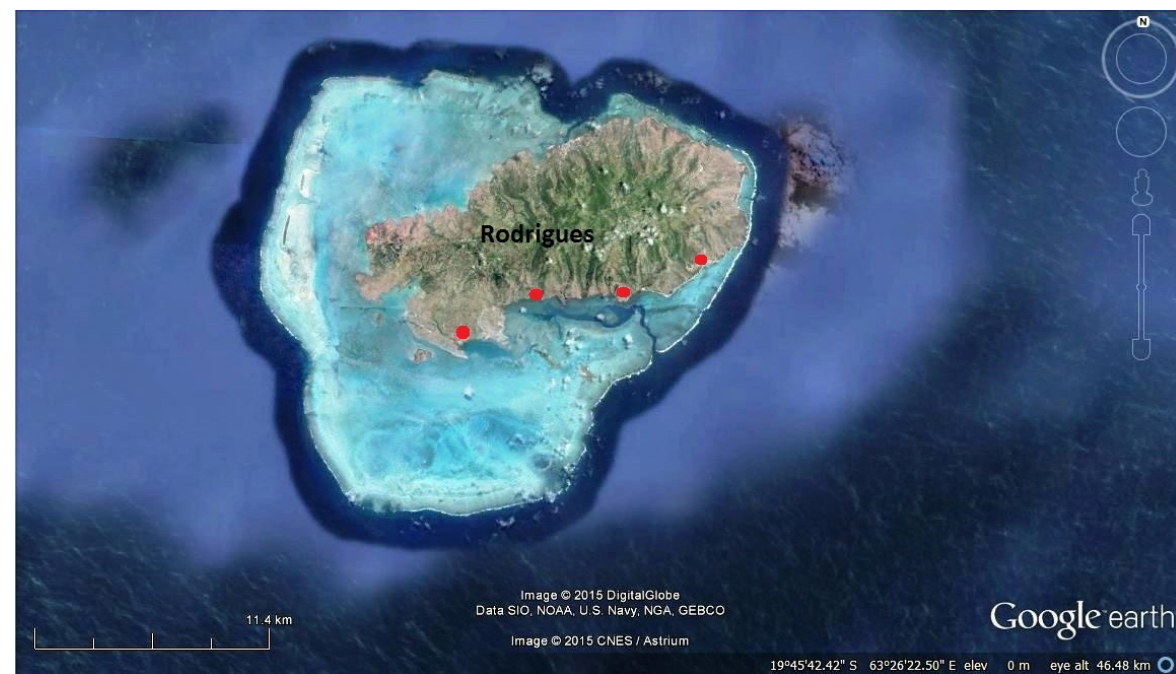
Image 3. Historic distribution (red dots) of Aerva congesta in